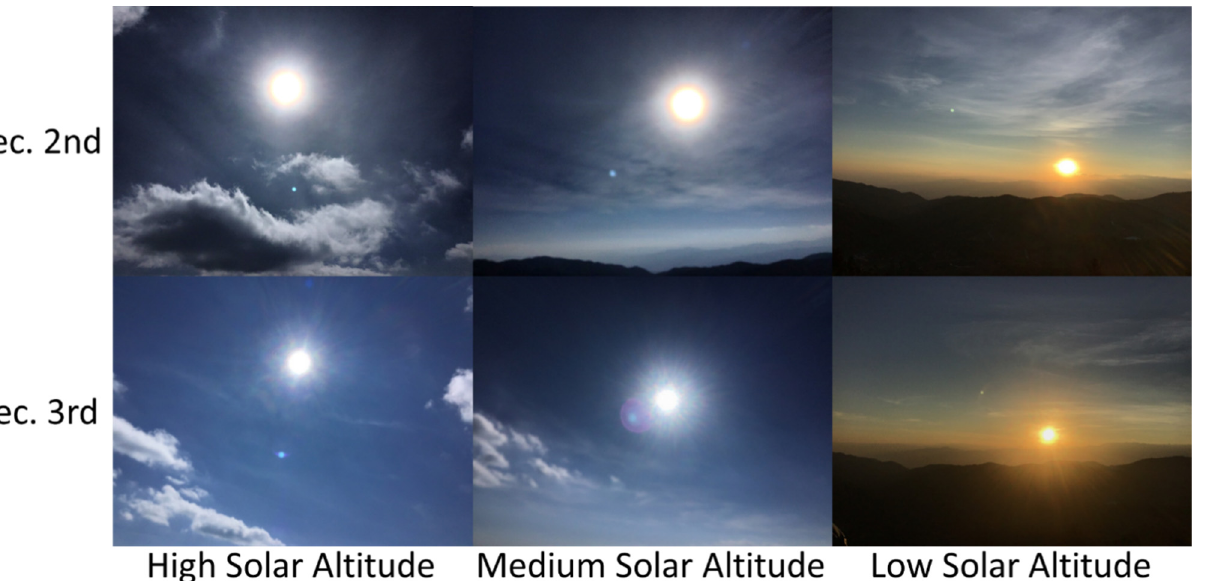
Figure 19. Weather during the continuous observations of the afternoon of 2 and 3 December.